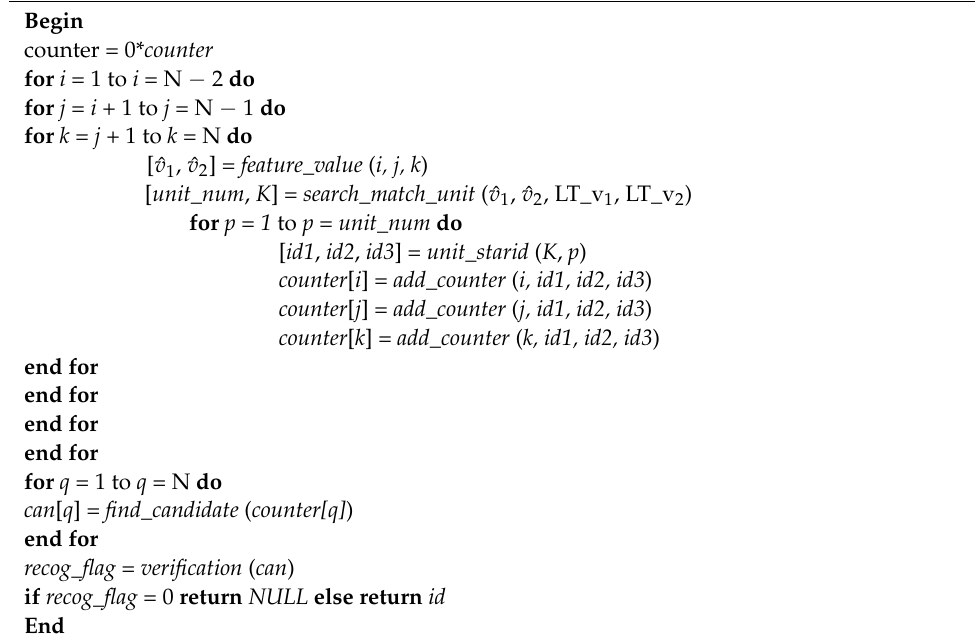
Algorithm 1 The pseudocode of the proposed algorithm